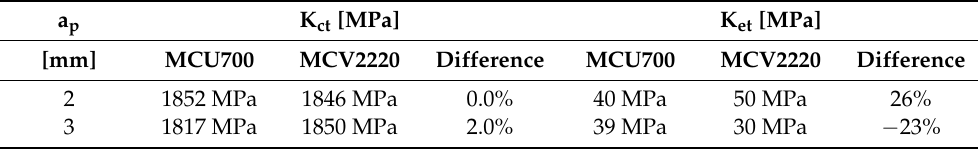
Figure 9. Dependence of the tangential cutting force component on the feed per tooth: ( a ) for axial depth of cut 2 mm; ( b ) for axial depth of cut 3 mm. Table 4. Resulting coefficients, K ct and K et . MCU700 data were used as a reference (100%).